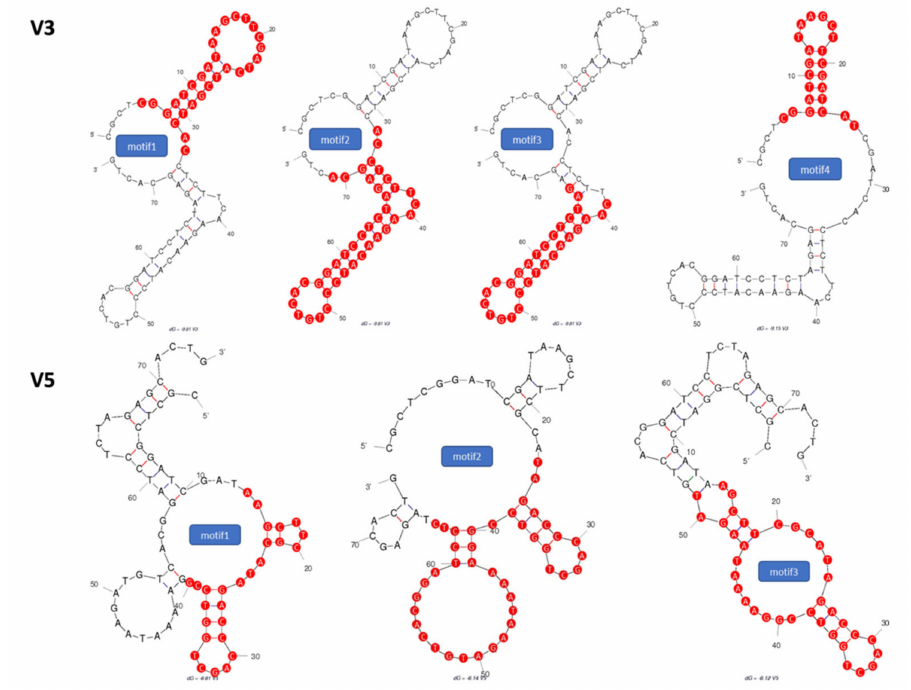
Figure 1. Secondary structures of selected ( V3 ) and ( V5 ) thio-aptamers. Proposed binding motifs are shown in red.